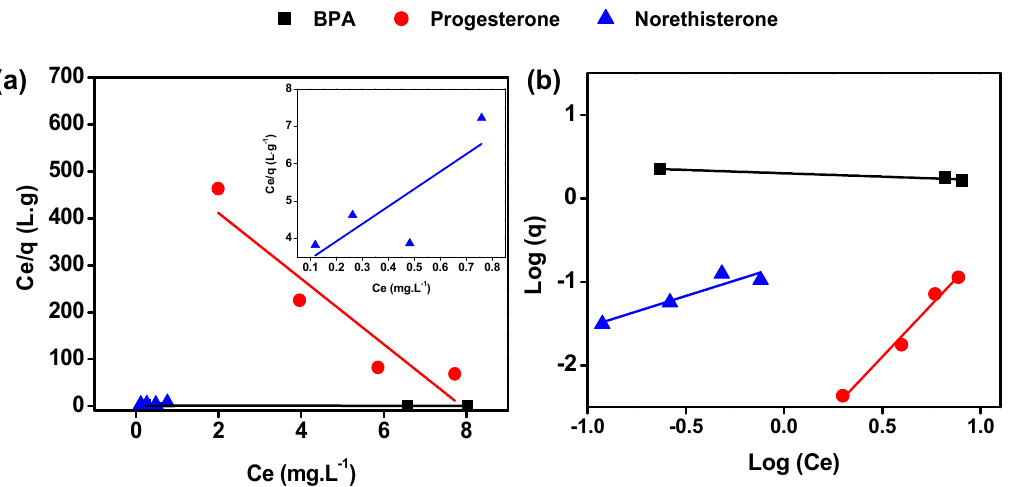
Figure 6. Linear regression plots of ( a ) Langmuir and ( b ) Freundlich adsorption models for BPA, progesterone and norethisterone. Inset of panel ( a ) is the Langmuir linear regression plot of norethisterone.